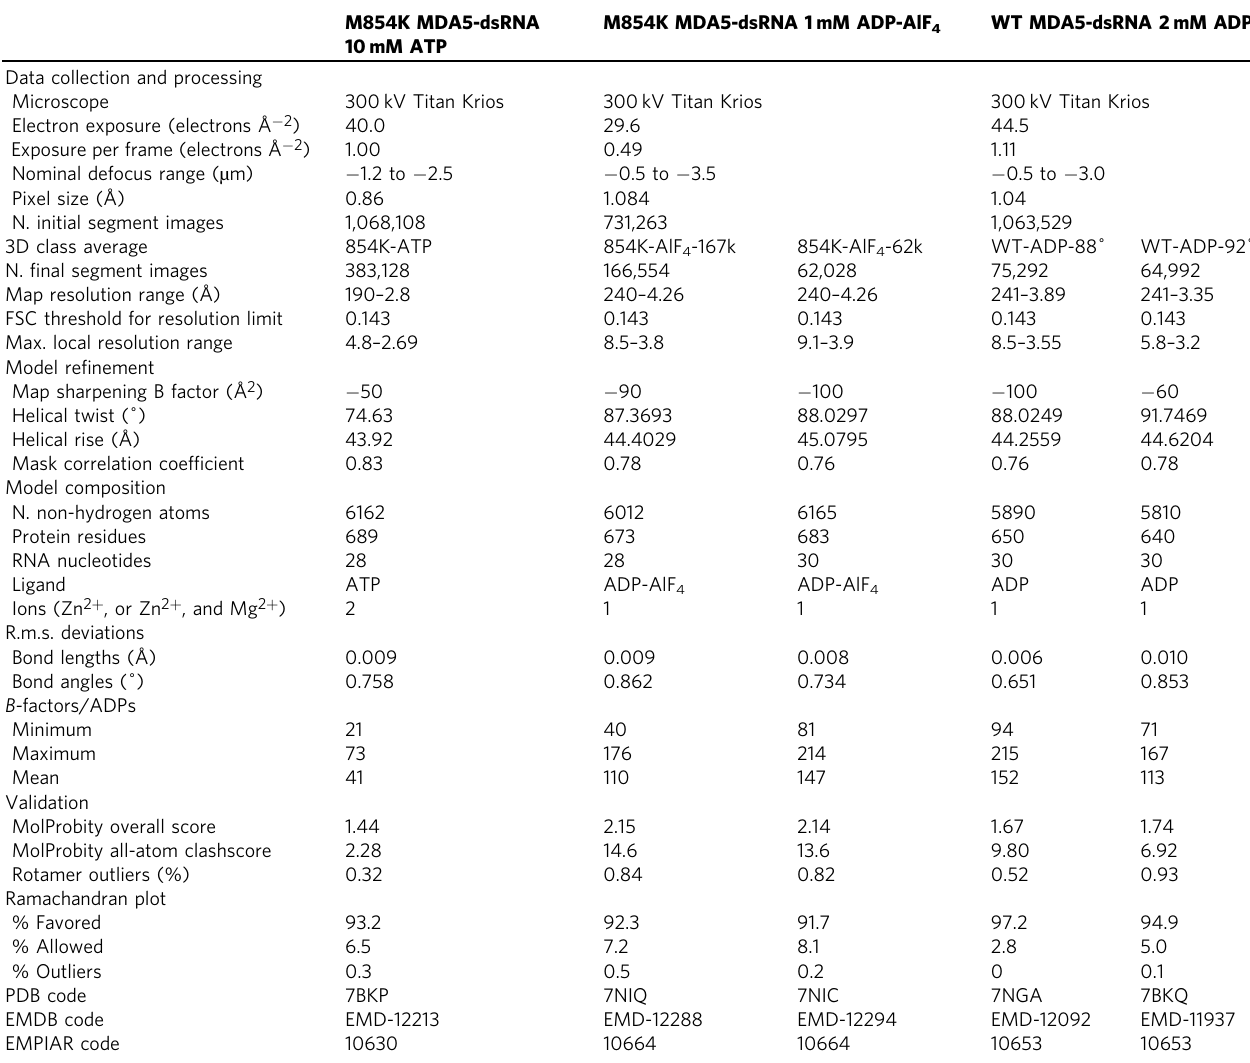
Table 1 CryoEM data collection, structure determination, and model re fi nement